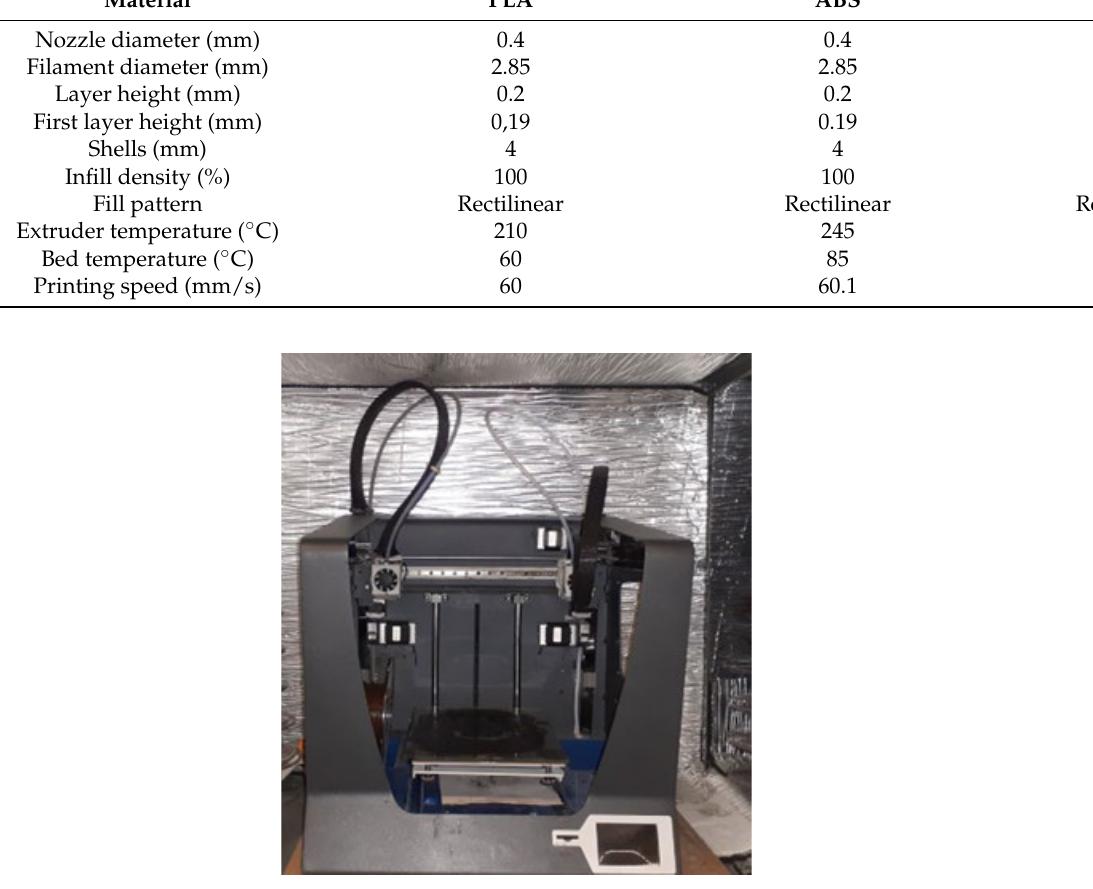
Figure 3. FDM type 3D Printer.